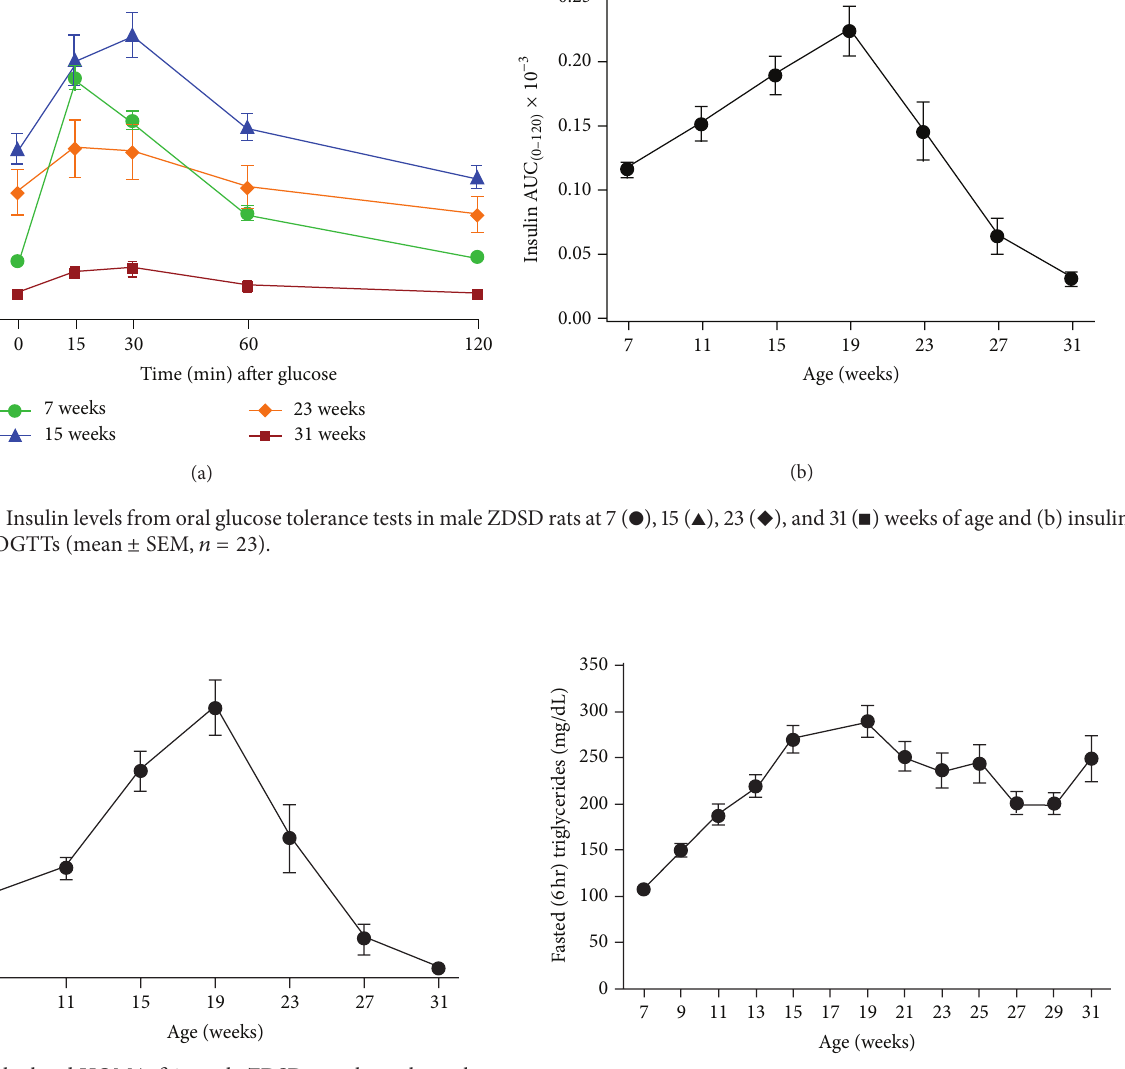
Figure 9: Fasted triglycerides in male ZDSD rats throughout the study duration of rats in ages from 7 to 31 weeks (mean ± SEM, 𝑛 = 23